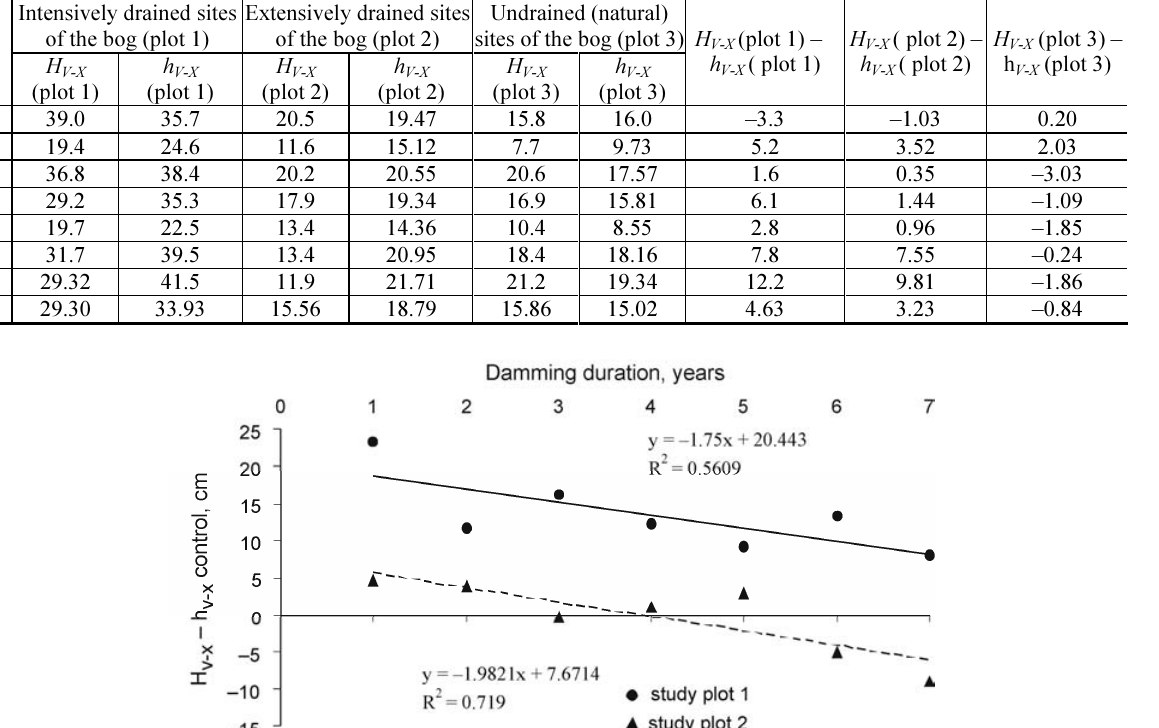
Table 3. Comparison between the observed ( H V-X ) and predicted ( h (V-X) ) water table depth in the restored bog of the Kamanos mire (prediction was made by functions 1 to 3)